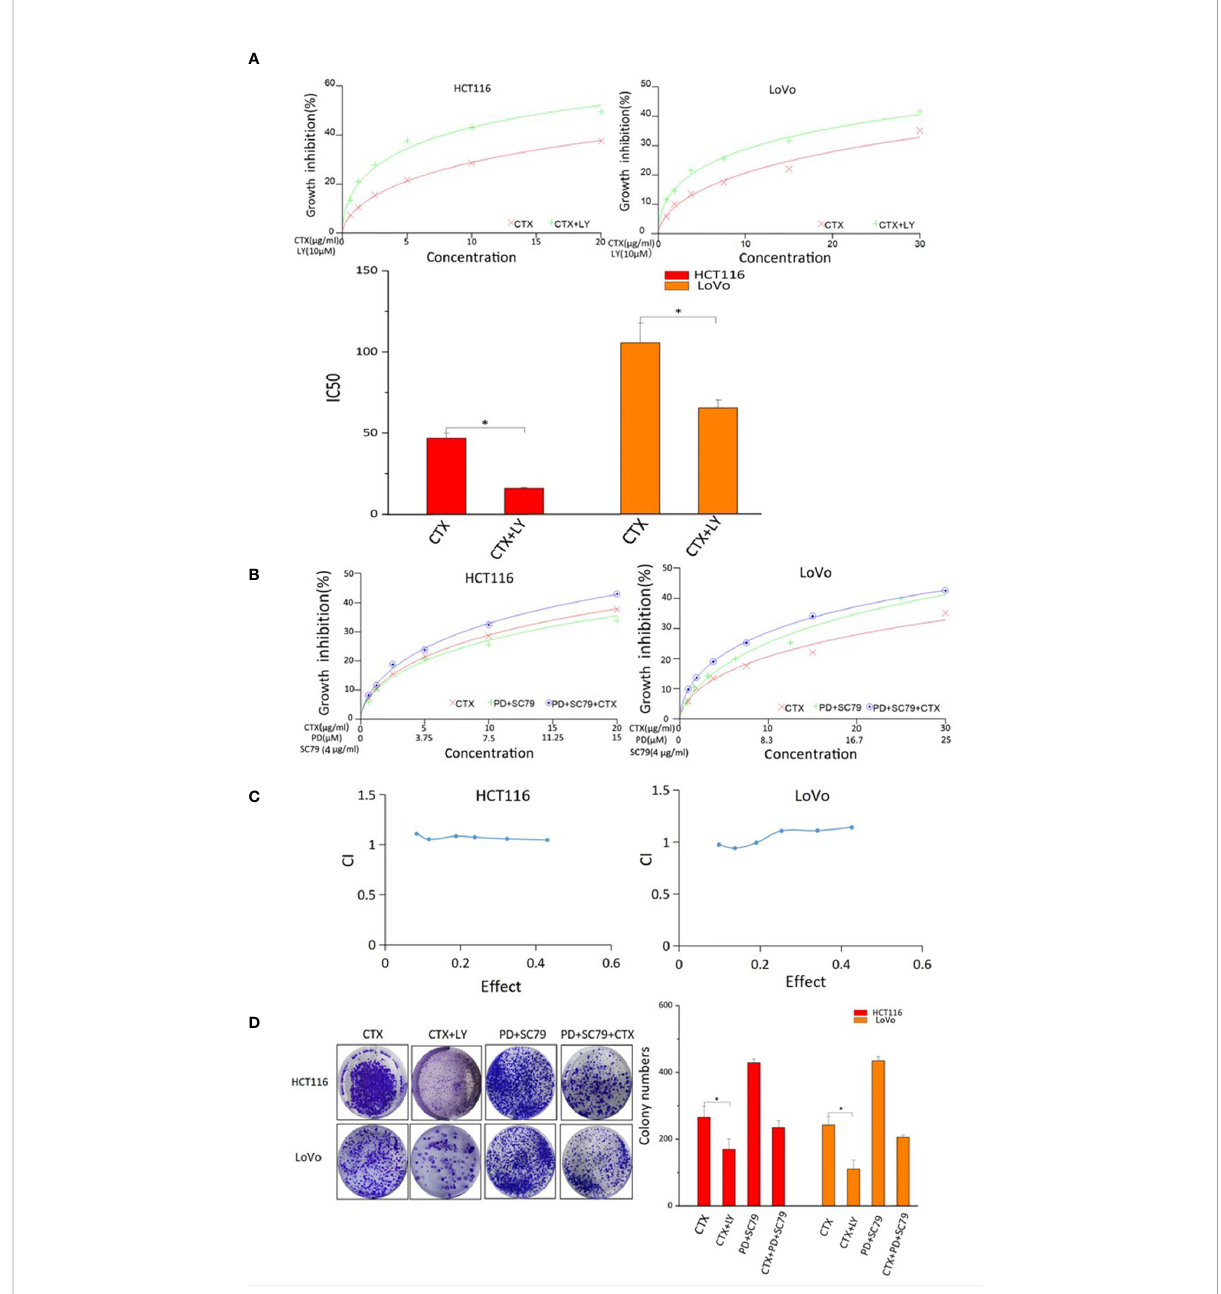
FIGURE 4 CCK-8 and colony-formation assay results of cells treated with PD, CTX, and Akt regulators. (A) The inhibitory effects of CTX and LY294002 treatment in HCT116 and LoVo cells were examined by CCK-8 assay after treatment for 48 h. ‘ LY ’ represents LY294002. The inhibitory effect of ‘ CTX+LY ’ is signi fi cantly higher than that of ‘ CTX ’ at all concentrations, as determined by one-way ANOVA ( P< 0.05). (B) SC79 (4 m g/ml) was administered concomitantly with PD. The inhibitory effects of PD+SC79 and/or CTX treatment in HCT116 and LoVo cells were examined by CCK-8 assay after treatment for 48 h. (C) The CCK-8 assay results of PD+SC79 and/or CTX treatment were analyzed with the CalcuSyn software. Combination Index (CI) was calculated by the Calcusyn software. CI < 1 was considered synergistic, CI = 1 Tadditive, and CI > 1 antagonistic cytotoxicity. (D) The colony-formation assay was performed, and the results are displayed as colony numbers in the column diagram. HCT116 cells were treated with 5 m M PD and 10 m g/ml CTX, whereas LoVo cells were treated with 6 m M PD and 20 m g/ml CTX. Cells were treated with 4 µg/ml SC-79 and 10 µM LY294002. ‘ LY ’ represents LY294002. Columns showed mean ± S.D. ‘ CTX ’ was compared with ‘ CTX+LY ’ or ‘ CTX+PD+SC79 ’ using one-way ANOVA. * P < 0.05 represents a signi fi cant